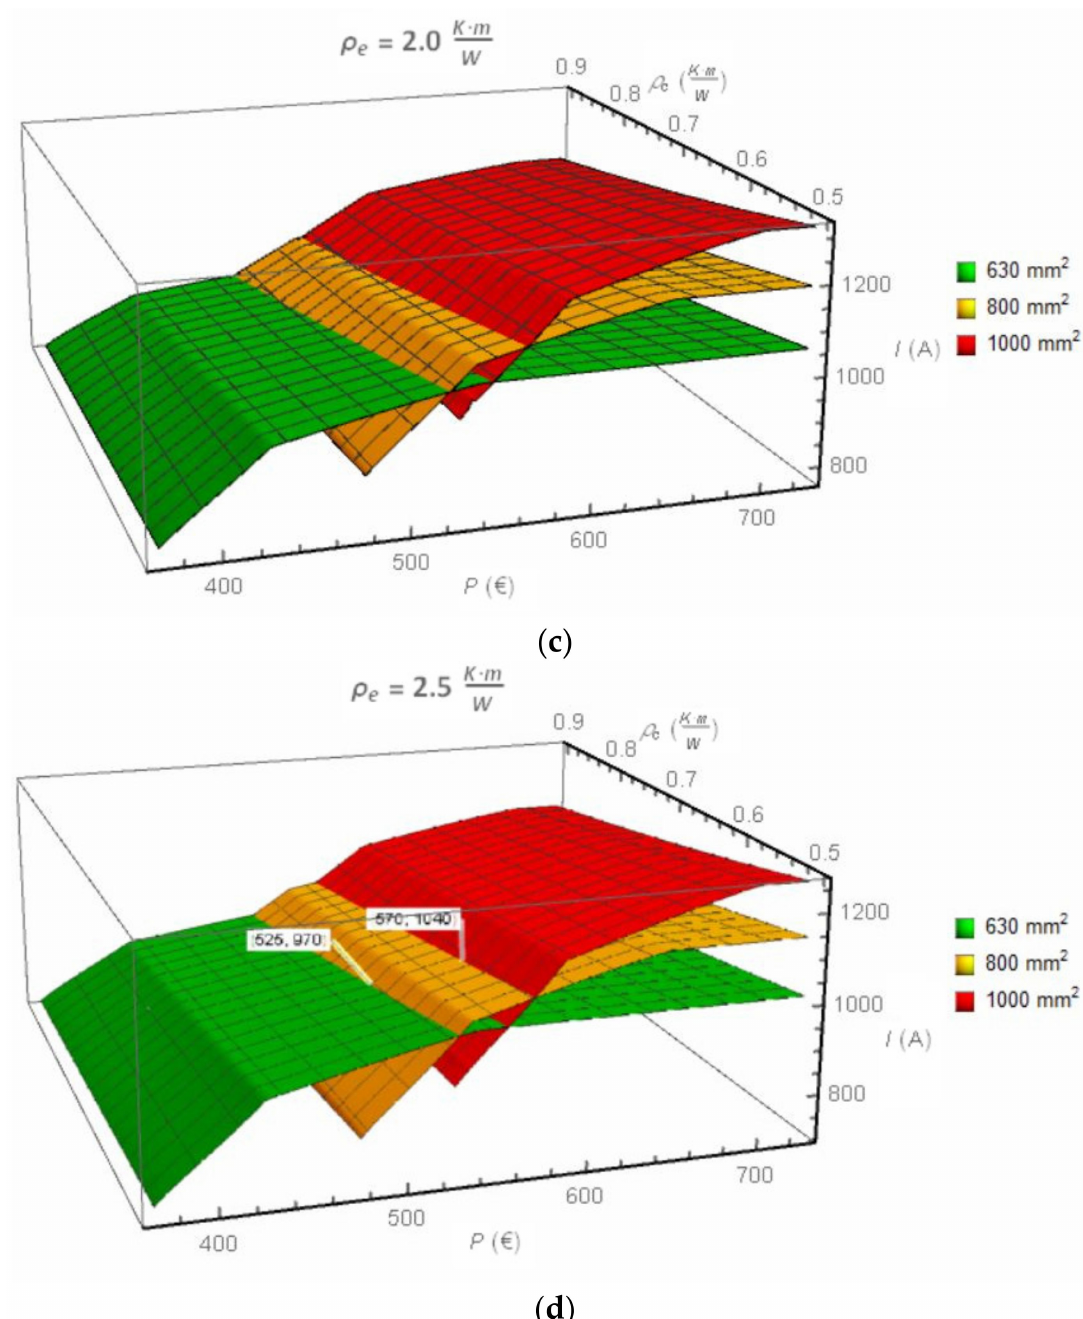
Figure 3. Ampacity I of the cable line with cables (630 mm 2 , 800 mm 2 and 1000 mm 2 ) laid in the flat formation, as a function of costs P and thermal resistivity of the backfill ρ c ; thermal resistivity of the native soil: ( a ) ρ e = 1.0 (K · m)/W; ( b ) ρ e = 1.5 (K · m)/W; ( c ) ρ e = 2.0 (K · m)/W; ( d ) ρ e = 2.5 (K · m)/W. Characteristic example points in ( d ): (EUR 525, 970 A) and (EUR 570, 1040 A)—the cost efficient transition to the cable of higher cross-section (for ρ c = 0.6 (K ·